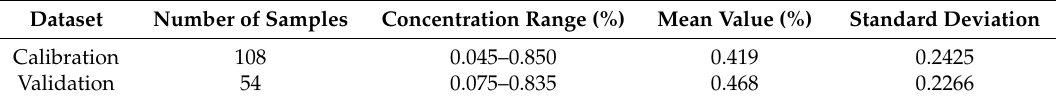
Table 1. Descriptive statistics for sample measurements.